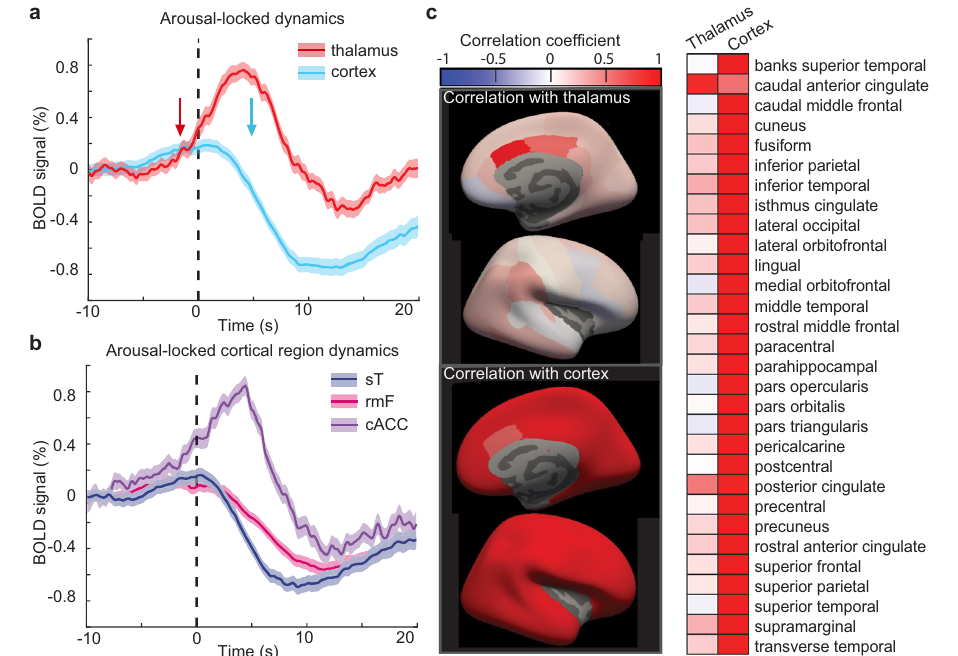
Fig. 2 | Thalamus activates seconds before behavioral arousal, while most of the cortex deactivates after arousal. a Arousal-locked blood oxygenation-level- dependent(BOLD)signalsinthewholecortexandthalamus.Thalamus(red)begins to activate (20% latency denoted by red arrow) seconds before behavioral arousal (vertical dashed line), while the cortex (blue) deactivates afterward (blue arrow). Datawerepresentedasmeanvalues,andshadingrepresentsstandarderror. b Most of the cortex deactivates during arousal, but a subset of regions, including the caudalanteriorcingulatecortex(cACC,purple),activatebeforebehavioralarousal,